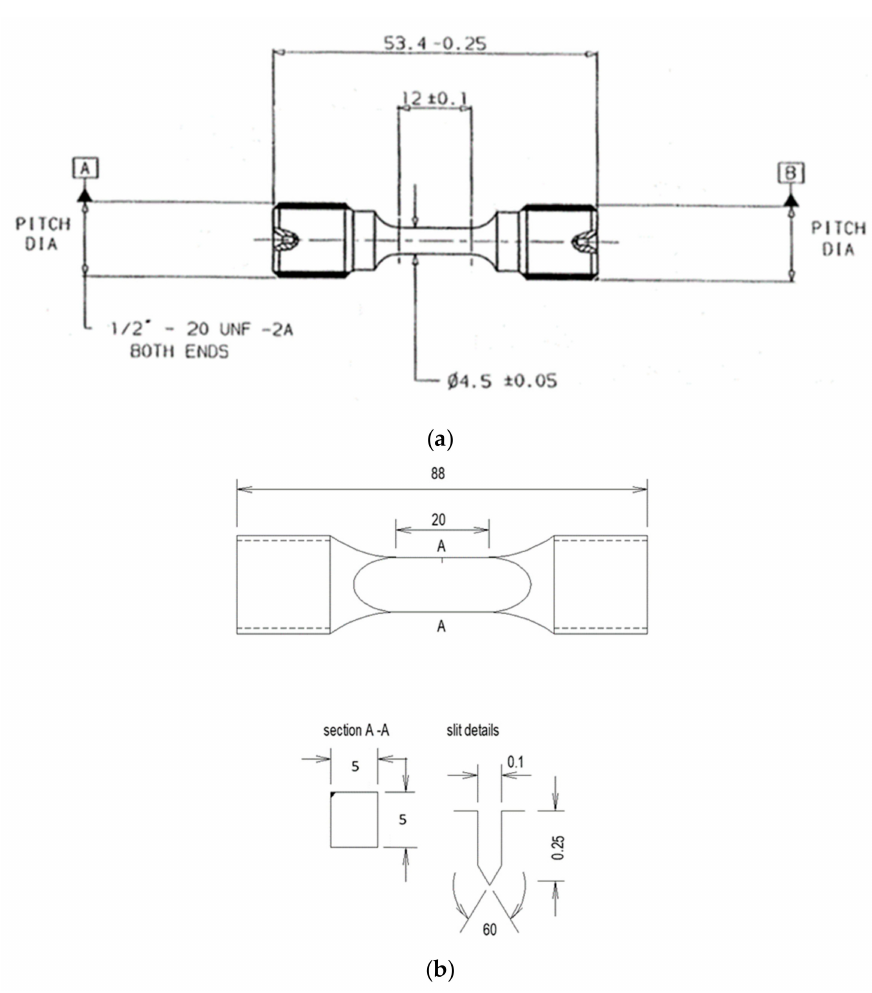
Figure 4. ( a ) Plain cylindrical tensile / fatigue specimen, ( b ) Fatigue crack growth specimen. All dimensions are in mm.